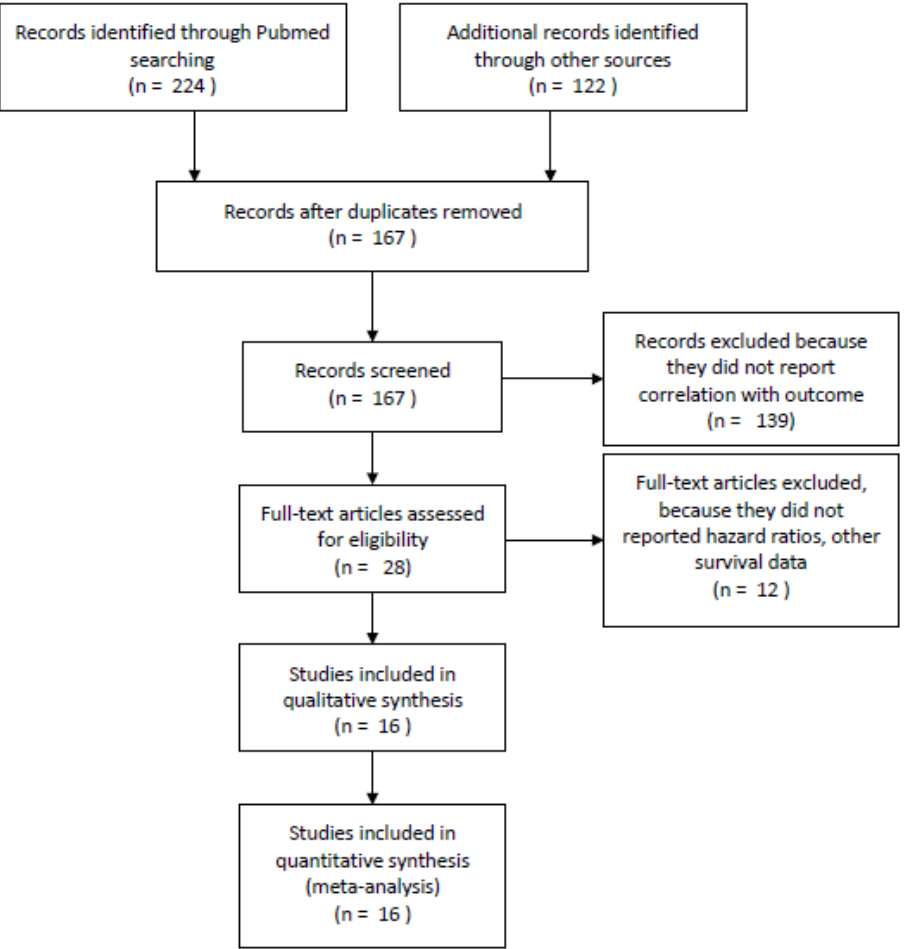
Figure 1. flow diagram of included studies. Figure 1. Flow diagram of included